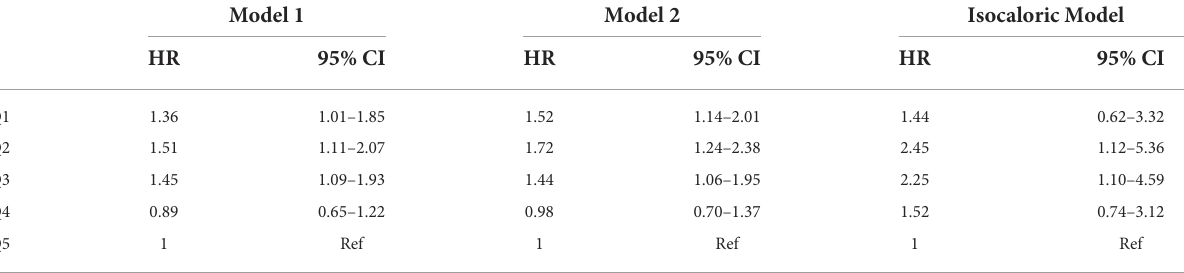
TABLE 6 Hazard ratio (95% confidence interval) of all-cause mortality for %E P z -score quintiles + isocaloric regression model. Model